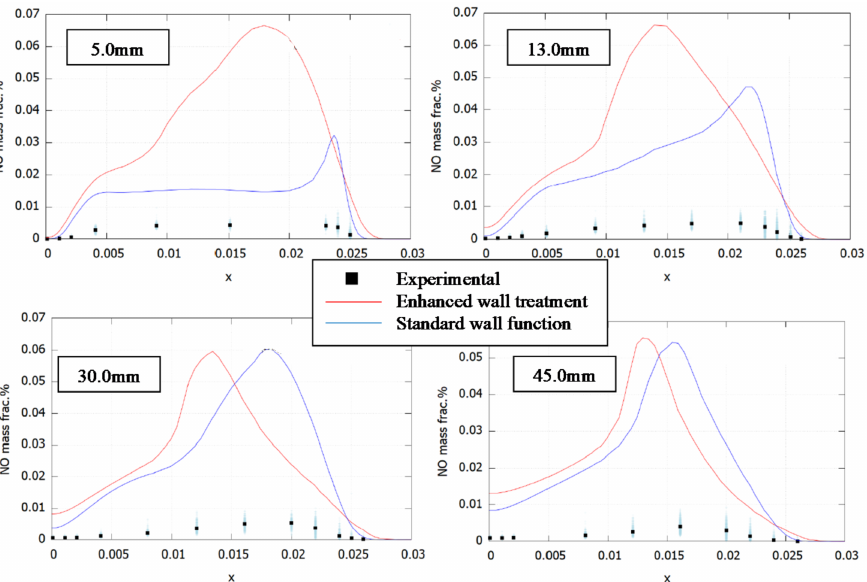
Figure 8. NO mass fraction profiles at increasing axial distances. SAGE/GRI-Mech 3.0. Complete experimental data available at reference